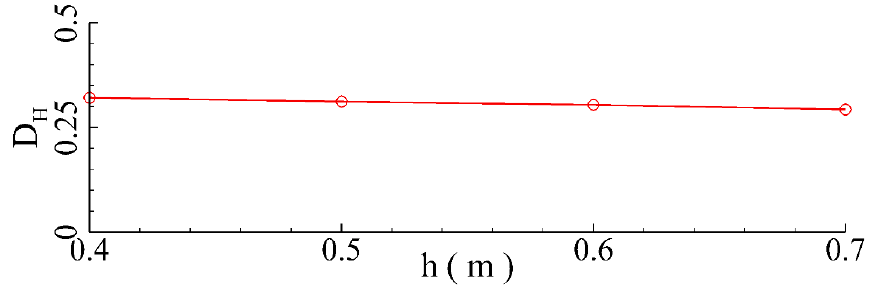
Figure 18. Dissipation rate of the local maximum wave height under different water depths.